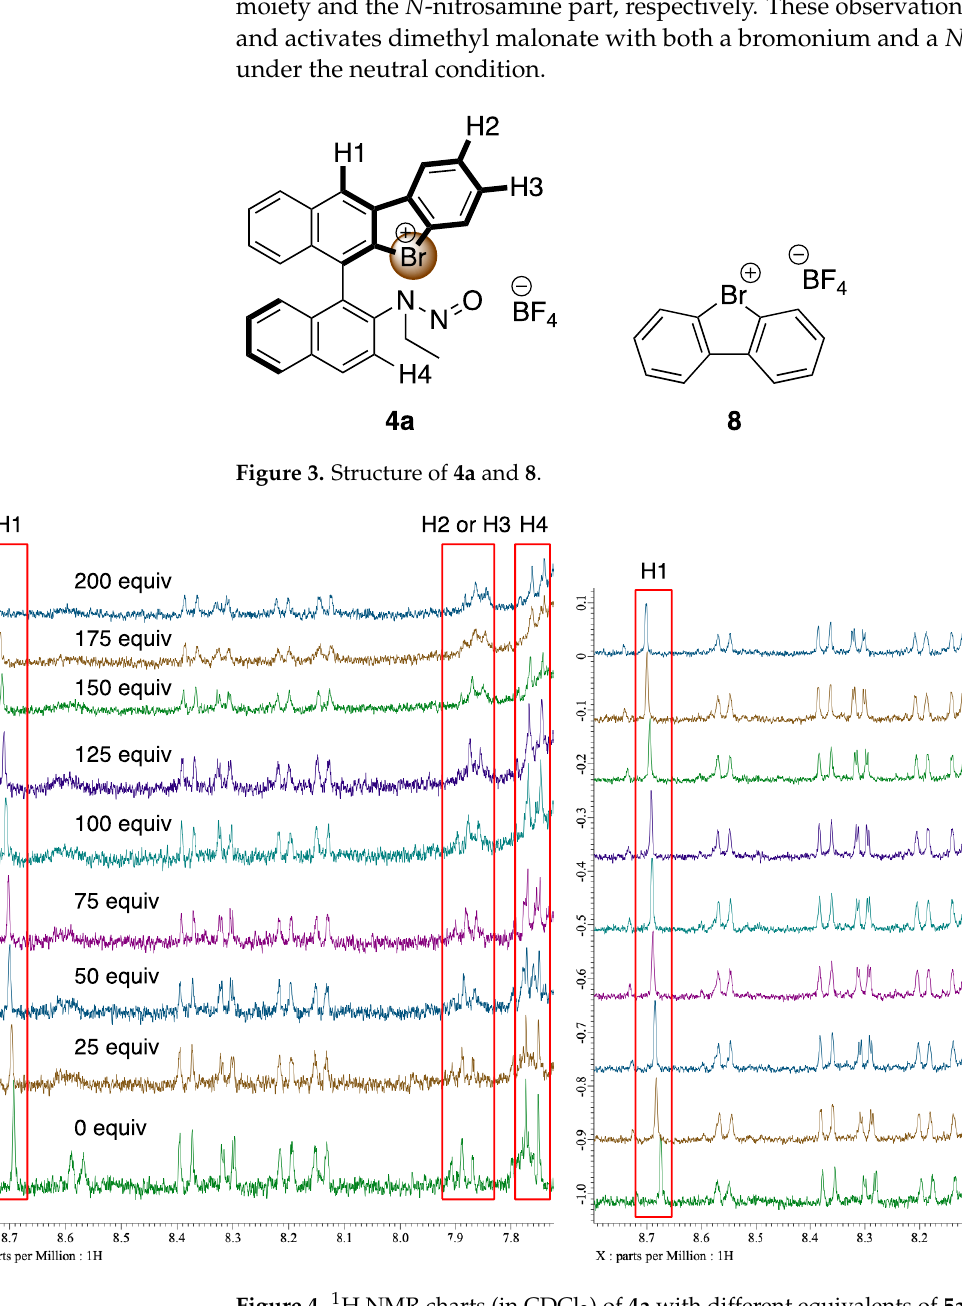
Figure 4. 1 H NMR charts (in CDCl 3 ) of 4a with different equivalents of 5a ( left ), and 6a ( right ).